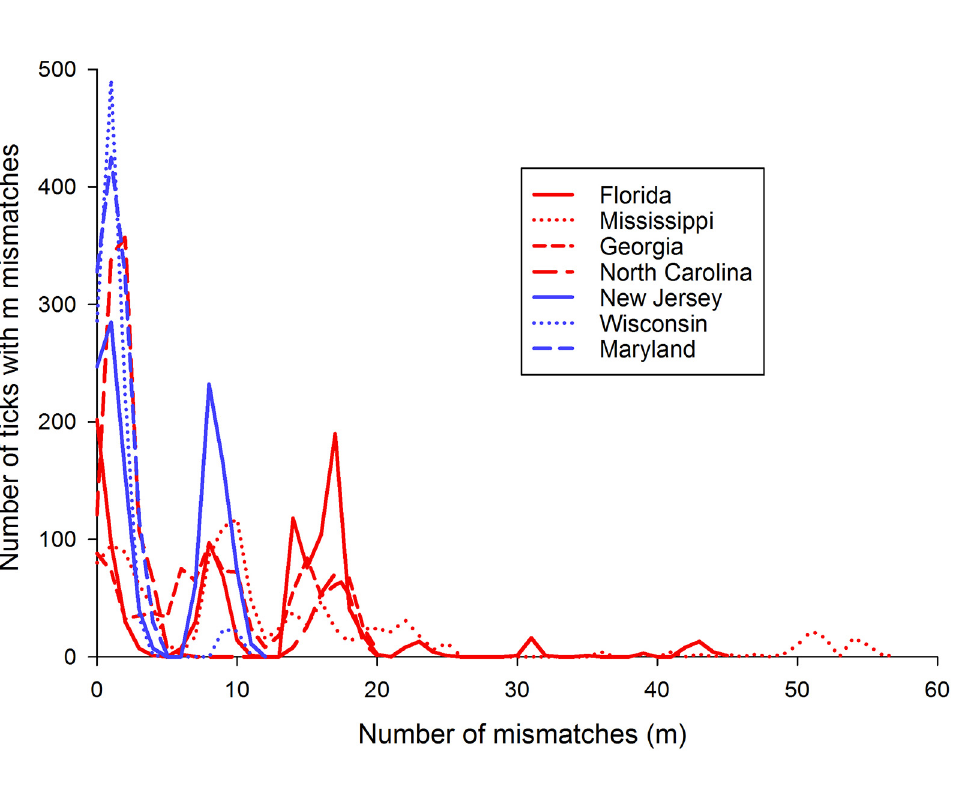
Fig 3. Mismatch distributions among the four southern collections (in red) and the three northern collections in blue.